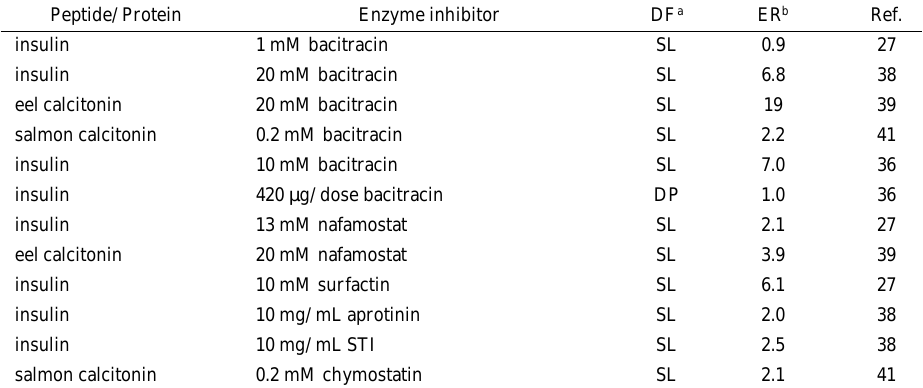
Table 2 Effect of enzyme inhibitors on pulmonary absorption of peptides and